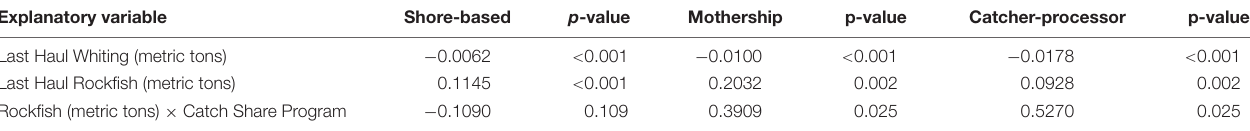
TABLE 3 | Fixed effects models of distance moved by sector.